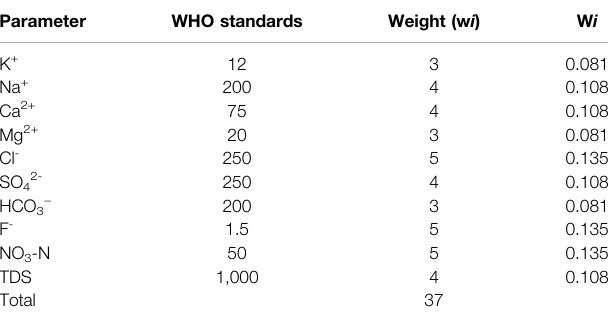
TABLE 2 | The weight, relative weight and WHO standards of each of the parameters used for the WQI determination. Parameter WHO